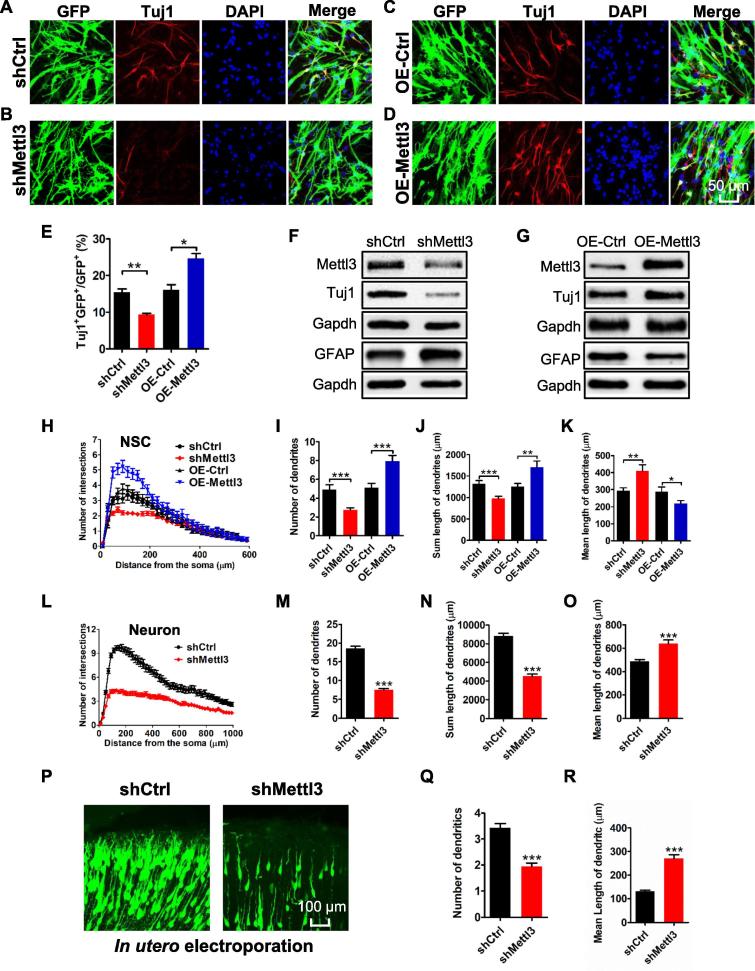
Mettl3 regulates the differentiation and neuronal development of aNSCsRepresentative immunofluorescence images of the differentiated aNSCs with neuronal cell marker Tuj1 of control (A, C), Mettl3 KD (B), and Mettl3 OE (D) groups. Scale bar, 50 μm. Quantification of Tuj1+ cells in differentiated aNSCs with Mettl3 KD and Mettl3 overexpression (n = 3) (E). Western blot assays showing the protein levels of the neuronal cell marker, Tuj1, and astrocyte marker, GFAP, in aNSCs (differentiation condition) with Mettl3 KD (F) and Mettl3 overexpression (G). Sholl analysis of newborn neurons generated upon the differentiation of aNSCs (H–K) (n = 40). Sholl analysis of cultured hippocampal neurons (L–O) (control group: n = 75; KD group: n = 66). Representative images of in utero electroporation (P). The quantifications of the number (Q) and length (R) of dendrites. Data are presented as mean ± SEM, unpaired t-tesst, *, P < 0.05; **, P < 0.01; ***, P < 0.001. Scale bar, 50 μm. OE, overexpression.